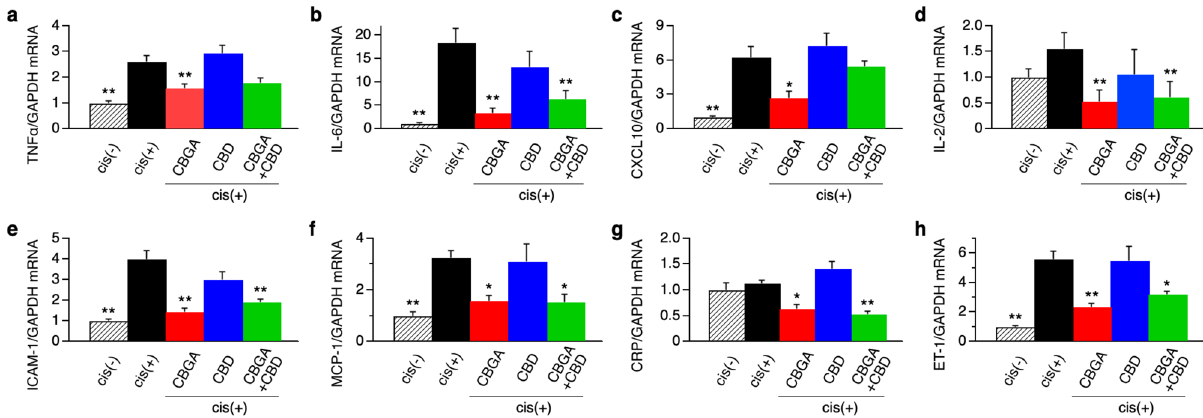
Figure 2. CBGA reduced the mRNA expression of inflammatory cytokines and proteins in cisplatin-induced acute nephropathy. The mRNA levels of TNFα ( a ), IL-6 ( b ), CXCL10 ( c ), IL-2 ( d ), ICAM-1 ( e ), MCP-1 ( f ), CRP ( g ) and ET-1 ( h ) were measured in kidneys of the cisplatin (+) group (black bars), the CBGA treatment group (red bars), the CBD treatment group (blue bars), and the CBGA + CBD treatment group (green bars) at day 3 (see numeric data in Supplementary Table S1). Shaded bars represent the non-cisplatin treatment group as a control group. *p < 0.05, **p < 0.01 vs. cisplatin (+)